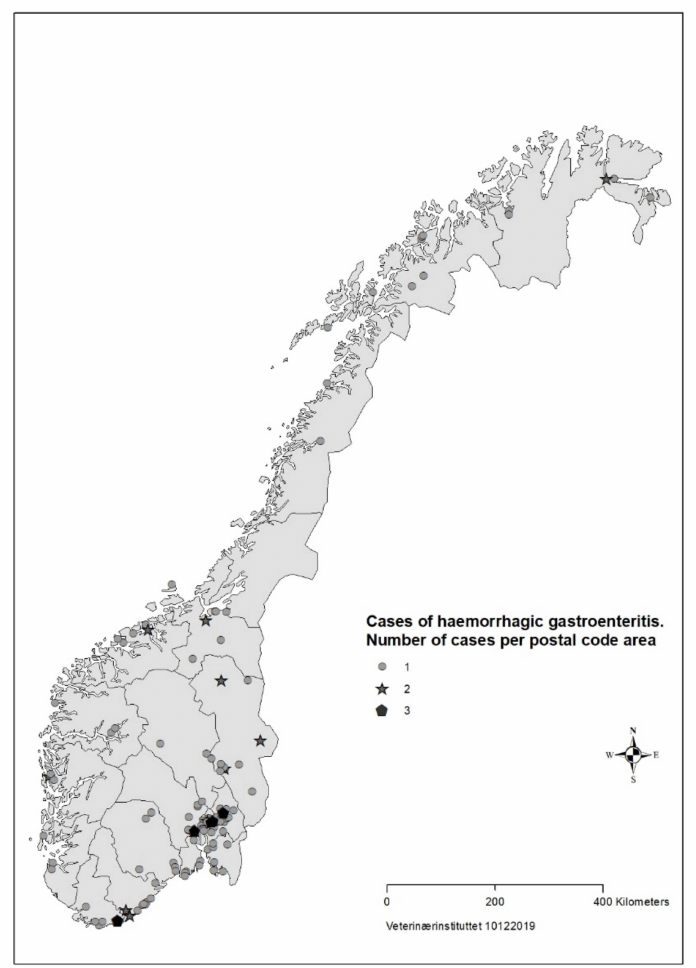
Figure 2. Geographical distribution of cases ( n = 207) with acute haemorrhagic diarrhoea in dogs with onset from 1 August to 30 September reported in survey to veterinarians, Norway 2019. The dogs were evenly distributed with respect to age, ranging from 11 weeks to 16 years, with a mean of six years and a median of five years. In total, 87 breeds were represented, and the most frequent were mixed breed ( n = 27), English Setter ( n = 11), Yorkshire Terrier ( n = 8), Golden Retriever ( n = 7), and six each for Tibetan Spaniel,